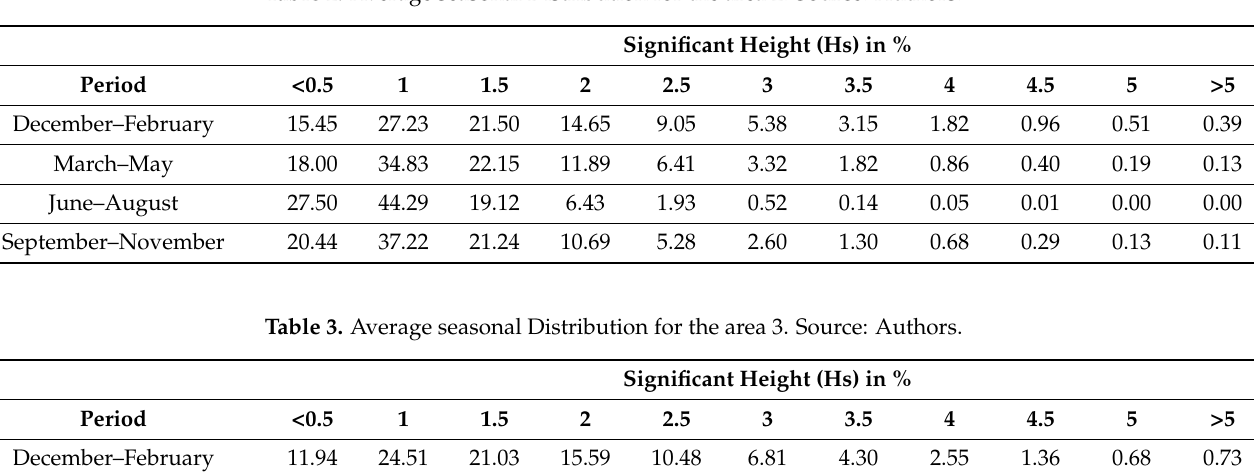
Table 2. Average seasonal Distribution for the area 2. Source: Authors.